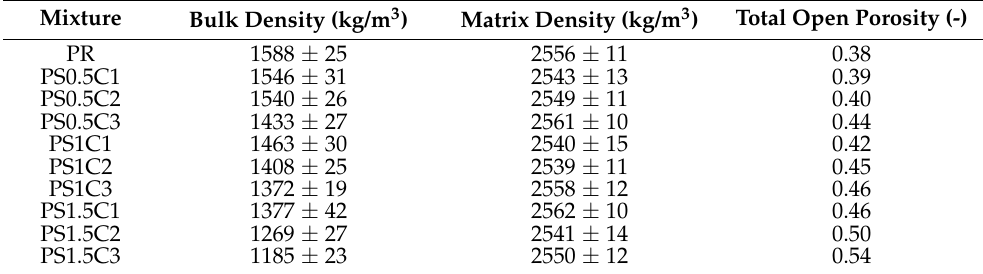
Table 2. Basic material properties of studied